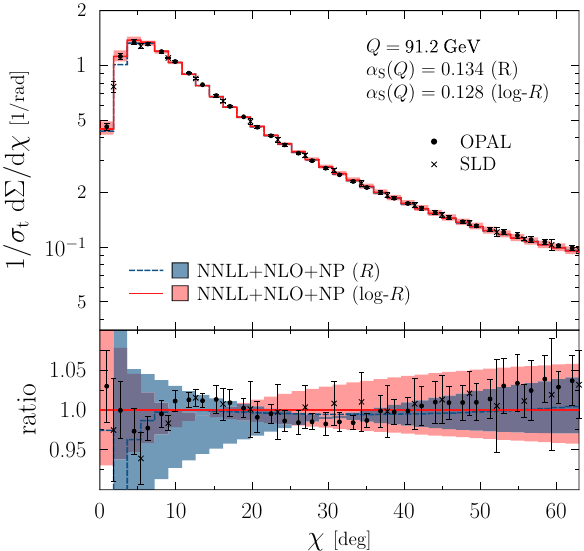
Fig. 6 NNLL + NLO matched predictions for EEC in the R and log- R matching schemes. The analytic model of Eq. (4.1) is used to account for hadronization corrections. The bottom panel shows the ratio of the data and the R matched prediction to the log- R matched result. The bands represent the effect of varying the renormalization scale in the range μ ∈ [ Q / 2 , 2 Q ] with two-loop running of α